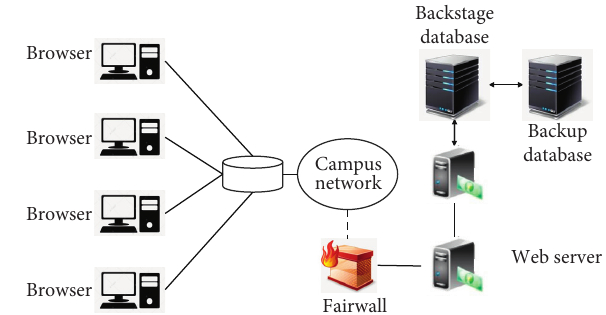
Figure 2: System topology diagram.